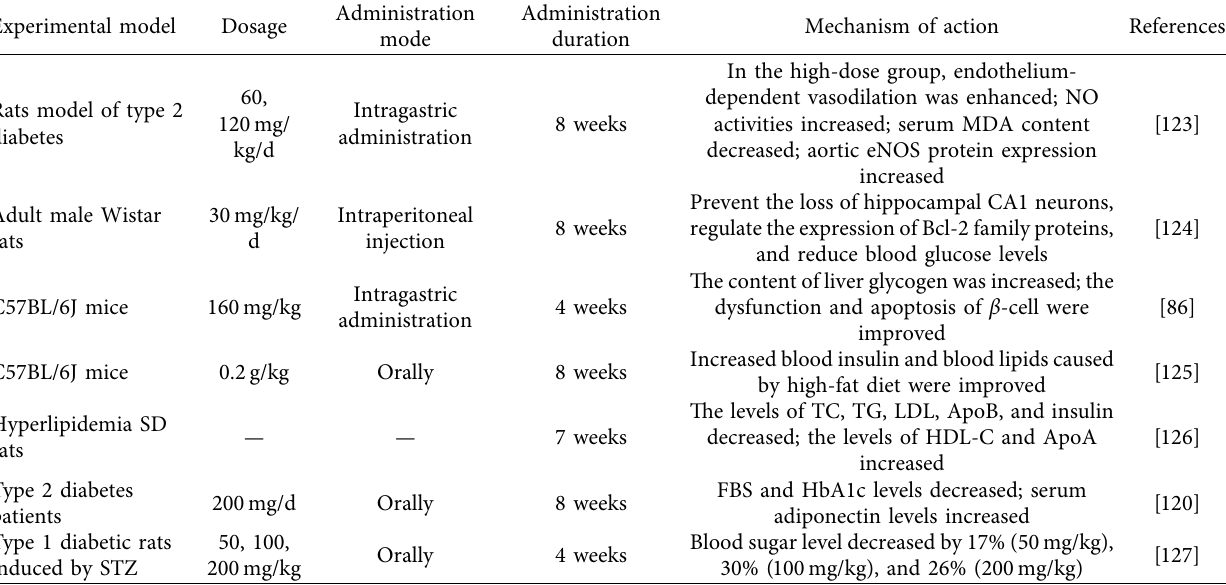
Table 7: Effects of sesamin on diabetes.